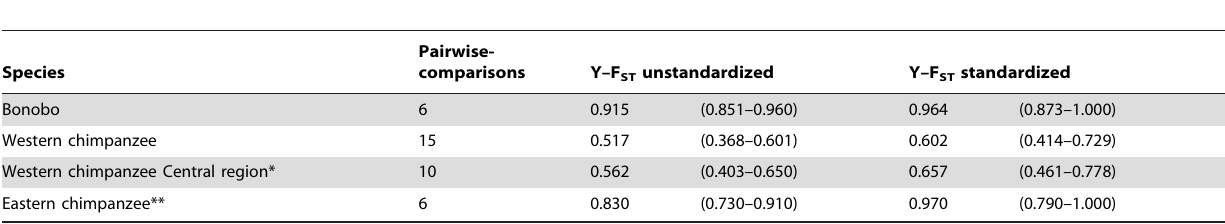
Table 2. Unstandardized and standardized Y–chromosomal genetic differentiation (with 95% confidence interval) in bonobo and chimpanzee groups.